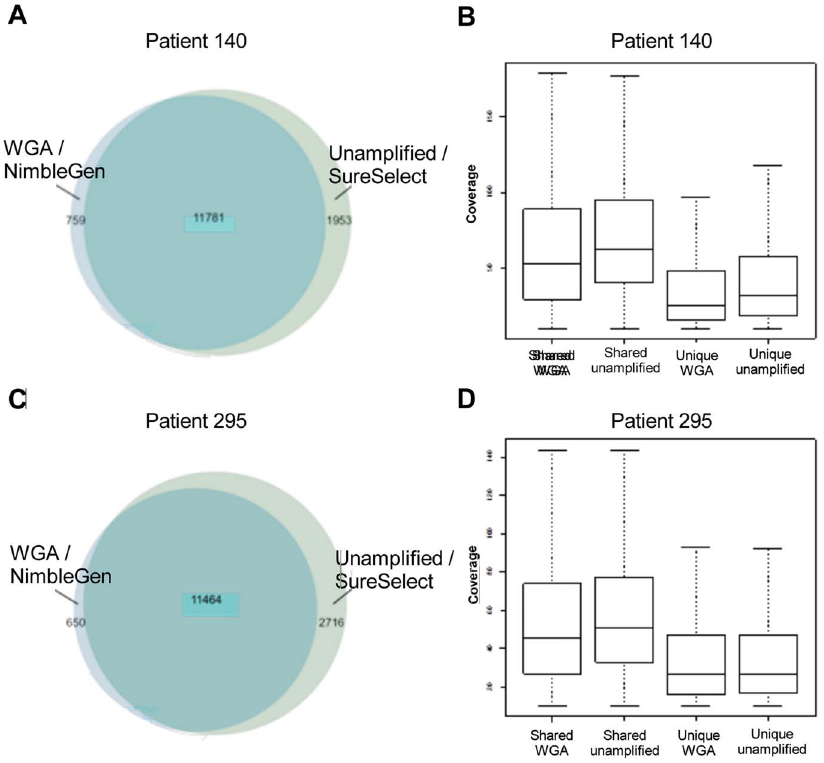
Figure 1. Genetic variants unique or shared between analysis. A) Venn diagram illustrating the distribution of SNVs for patient 140. Unique variants found by WGA are represented in light blue, and unique variants found without amplification are shown in light green. Shared variants identified by both methods are shown in green. B) Boxplot of the coverage of genetic variants found uniquely by WGA, without amplification, and with both methods for patient 140. The two leftmost boxes represent shared variant calls with coverage in those positions for WGA and without amplification, respectively. The two rightmost boxes represent the coverage over unique positions for each method. C) Venn diagram illustrating the distribution of SNVs for patient 295. Unique variants found by WGA are represented in light blue, and unique variants found without amplification are shown in light green. Shared variants identified by both methods are shown in green. D) Boxplot of the coverage of genetic variants found uniquely by WGA, without amplification, and with both methods for patient 295. The two leftmost boxes represent shared variant calls with coverage in those positions for WGA and without amplification, respectively. The two rightmost boxes represent the coverage over unique positions for each method. doi:10.1371/journal.pone.0084785.g001 PLOS ONE |